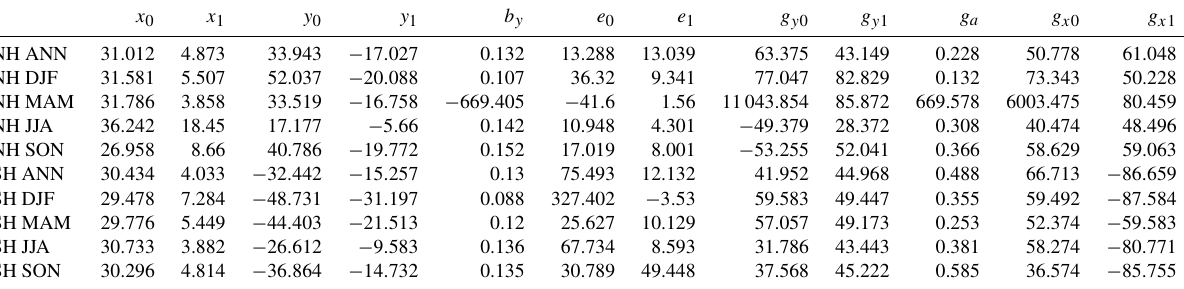
Table B1. Parameter values for extra-tropical origin fractions ϕ i, seas calculated with Eq. (B4) by hemisphere and season.